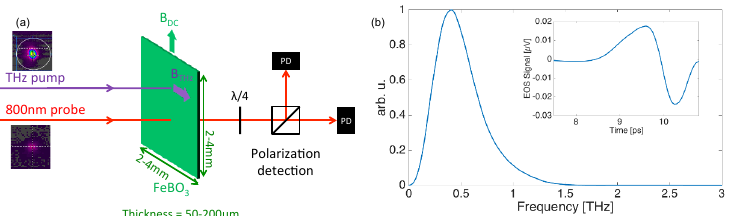
Fig. 1. ( a) Experimental setup of the dynamically resolved terahertz spectroscopy of FeBO3: a quarter waveplate, Wollaston prism and two balanced photodiodes measure the polarization rotation of the probe induced by the strong THz pulses. PD: photodiode. Insets: spatial profile of the pump and probe beams. (b) Spectrum of the THz excitation pulses with the electro-optical sampling trace in inset. We first characterized the transmission of the FeBO samples in a commercial time- 3 domain spectrometer for THz, in absence of an external magnetic field. Due to the irregular thickness of our sample, this measurement gives a range for the values of the refractive index and absorption. At 0.38 THz frequency, the refractive index is located between 1.50 and 2.96, while the absorption coefficient lies between 173 cm -1 and 597 cm -1 . The calculated Fresnel losses span then 4% to 25% on each interface, and a THz pulse twice reflected on both interfaces is delayed by 2-4 ps. The strong absorption coefficient implies that ~28-29 µJ of the single-cycle pulses are absorbed. The linear spectroscopic properties of our sample were measured with a commercial photo-spectrometer. The optical birefringence was not measurable, due to the poly-crystalline growth. The absorption, assuming 50 µm sample thickness, is close to the value reported in the literature [7].